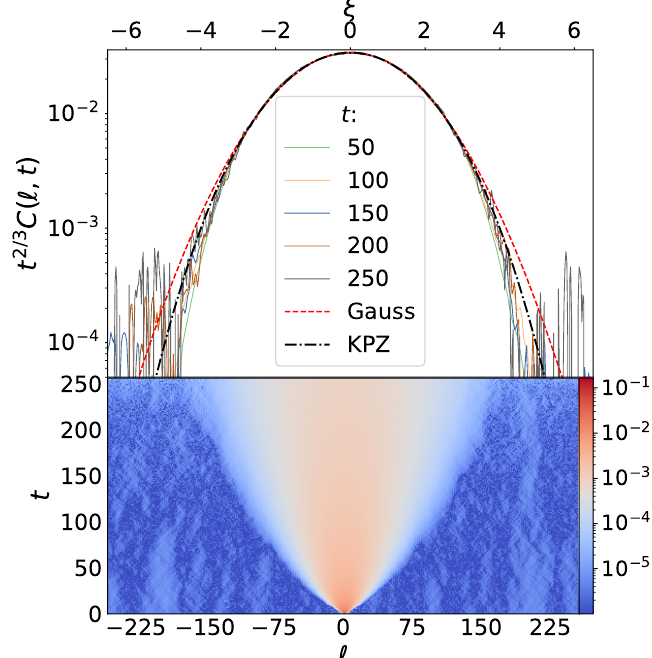
Figure 8: Dynamics of Noether charges in an invariant unbiased maximum-entropy state for the matrix model with G = USp ( 4 ) and the Lagrangian Grassmannian L ( 2 ) as the local phase-space manifold, showing relaxation of the charge correlator (bottom panel) and convergence towards stationary KPZ scaling profile (top